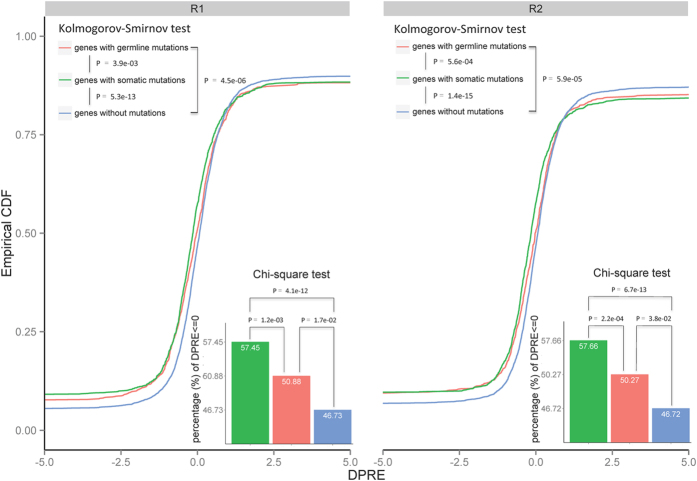
Empirical cumulative density of the DPRE in genes within three groups: with somatic mutations, with germline variations, and without mutations.R1 and R2 are the two independent MS experiments, and the two combined RNA-Seq data sets were used to calculate DPRE. The Kolmogorov–Smirnov test was performed to test whether the distribution of any two of the groups significantly differed. The inserted bar chart illustrated the percentage of genes with DPRE ≤ 0 in the three groups.